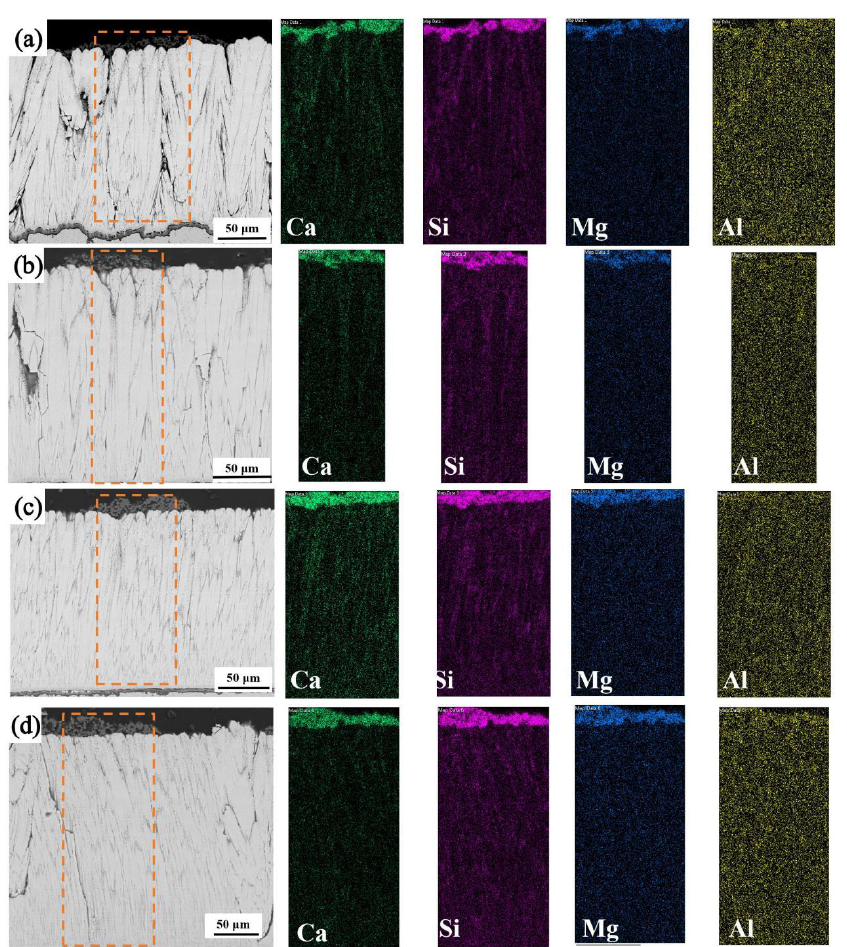
Figure 4. Cross-sectional morphologies and EDS maps of the 7YSZ coating after CMAS testing: ( a ) as-prepared sample; ( b ) 100# sample; ( c ) 400# sample; ( d ) 1200# sample (yellow dotted frame is the magnified area).